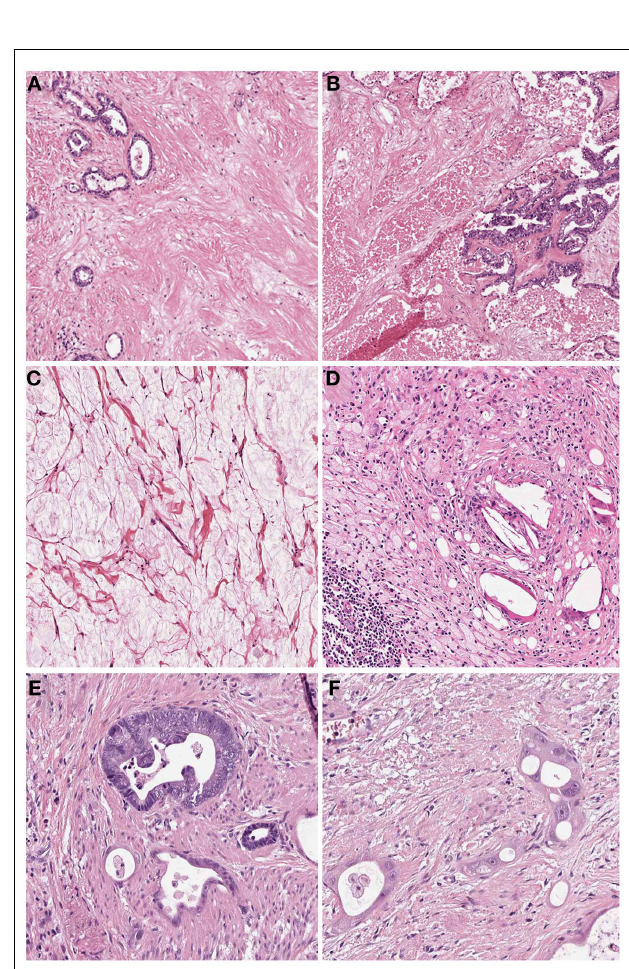
FIGURE 2 | Histologic findings of tumors treated by neoadjuvant (radio) chemotherapy . (A) Fibrosis replacing previous large parts of the tumor which is evident only by scattered residual tumor glands (Hematoxylin and Eosin (HE) stain, 10 × ); (B) Acute necrosis (HE stain, 10 × ); (C) Acellular mucin lakes (HE, 20 × ); (D) Foamy histiocytes and resorptive changes with cholesterol clefts and chronic inflammation (HE, 20 × ); (E) Regressive tumor gland adjacent to a better preserved viable gland (HE, 25 × ); (F) High grade cellular atypia in regressive tumor glands. Note